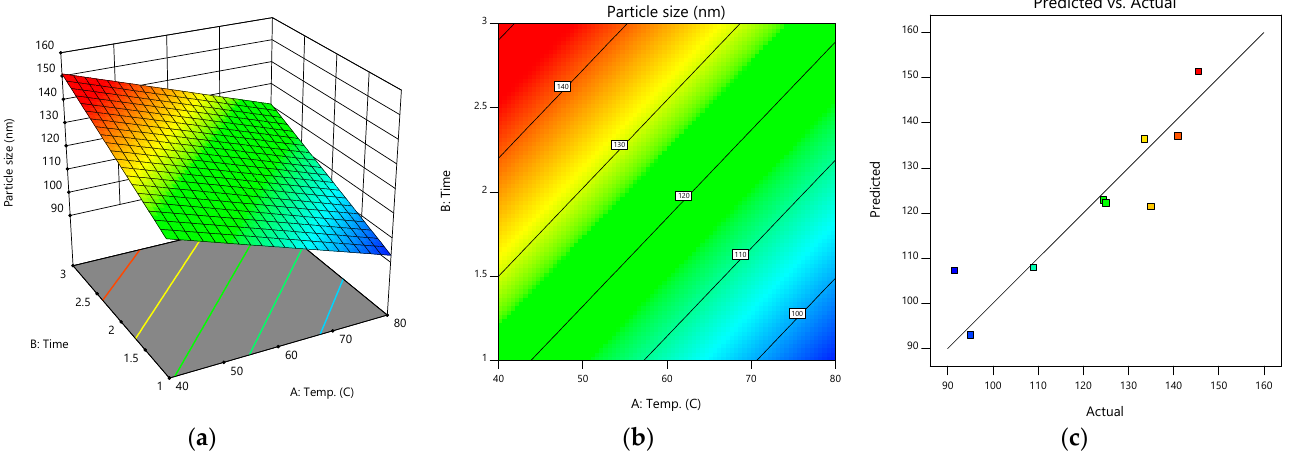
Figure 4. ( a ) 3D response surface, ( b ) contour plot, and ( c ) predicted versus actual plots of model conditions of silver-nanoparticle-complexed G. applanatum : temperature ( X 4 ) and time ( X 5 ) as independent variables and particle size as a dependent variable.